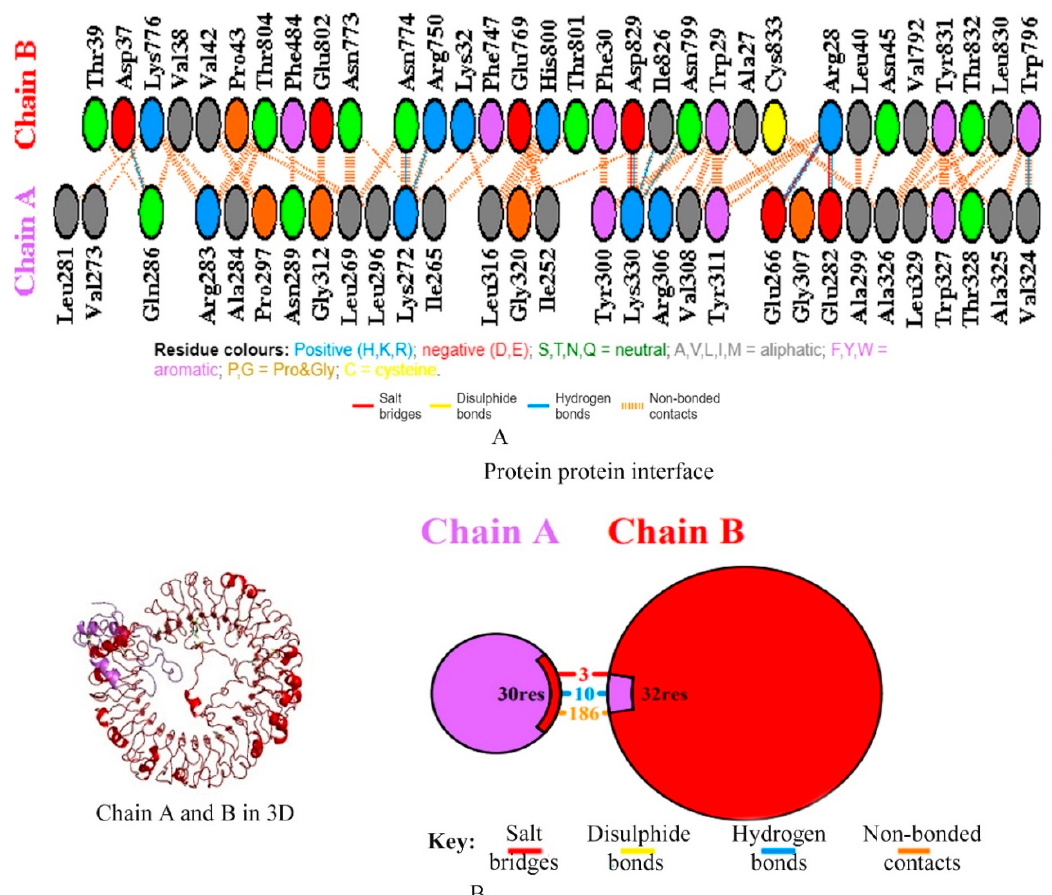
Figure 4. ( A ) The number of H-bond lines between any two residues indicates the number of potential hydrogen bonds between them. For nonbonded contacts, which can be plentiful, the width of the striped line is proportional to the number of atomic contacts. ( B ) Schematic diagram of interactions between protein chains. Interacting chains are joined by colored lines, each representing a di ff erent type of interaction, as per the key above. The area of each circle is proportional to the surface area of the corresponding protein chain. The extent of the interface region on each chain is represented by the black wedge whose size signifies the interface surface area. Chain A refers to a vaccine construct while chain B is toll-like receptor.